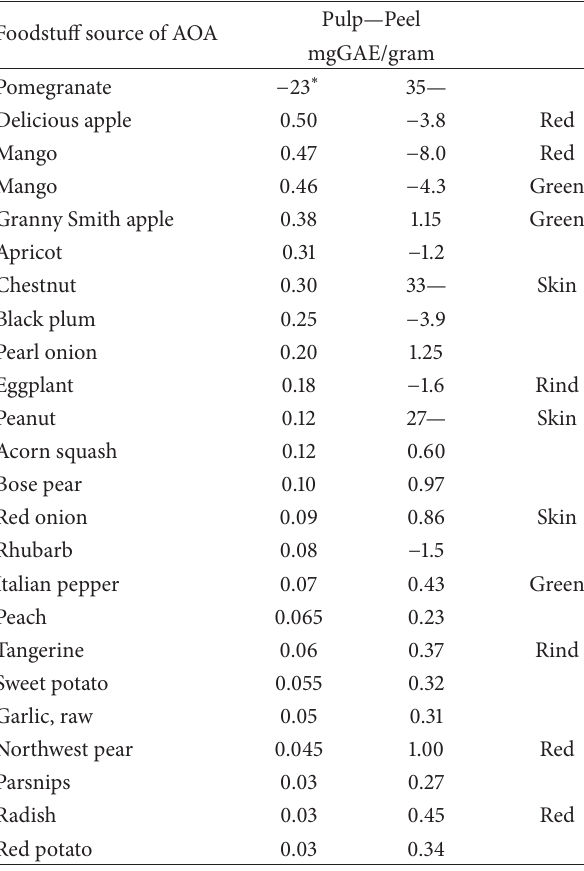
The pulp (or “membrane”) of pomegranate is not considered edible. Its high polyphenol content is not lost, however, since most pomegranates are crushed whole (with seeds) to recover the